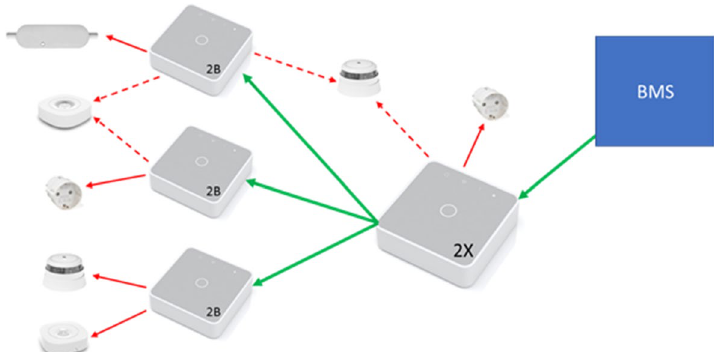
Fig. 2 Communication between gateways and